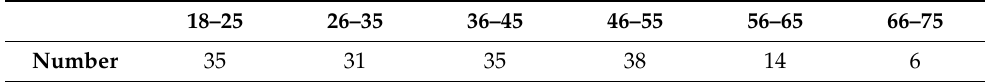
Table 2. Number of participants in each age range